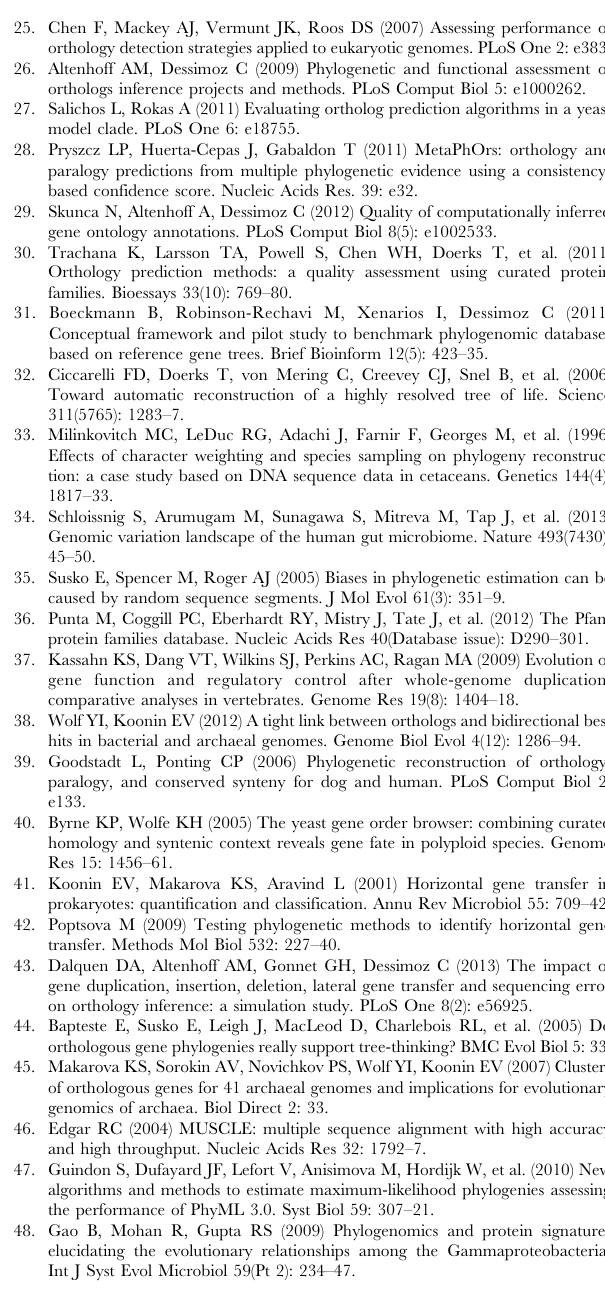
Data S1 Supporting tables. Table S1 , Information about the eukaryotic- and prokaryotic- Reference Orthologous Groups. Table S2 , Benchmarking eggNOG v3 using OrthoBench. Table S3 , Benchmarking eggNOG v3 using gene order. Table S4 , Benchmarking eggNOG v3 using enzymatic activity. Table S5 , Benchmarking eggNOG v3 using protein domain architecture. Table S6 , Table of the Pfam domain composition for xenologs and orthologs (true assignments). Table S7 , Benchmarking eggNOG v3, ToL Species, and ToL Genus orthologous groups using the reference orthologs for the 104 overlapping species.